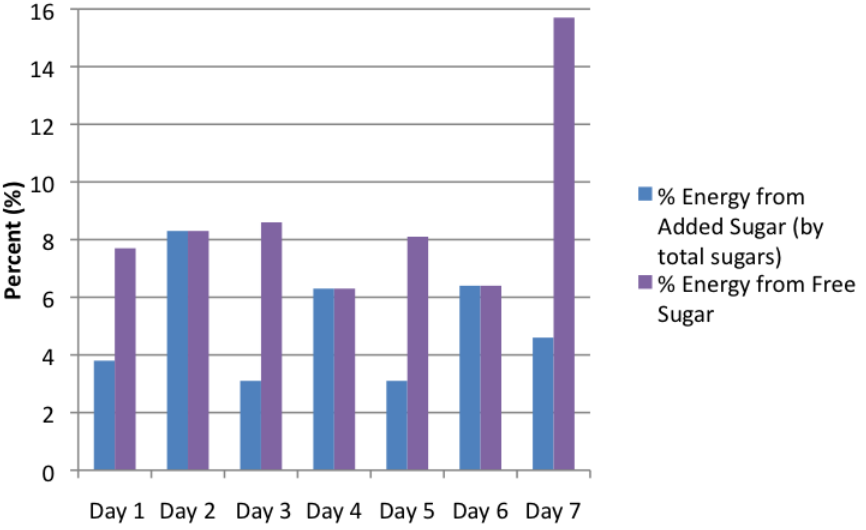
Figure 2. Percent energy from added sugar versus free sugar in the USDA sample menu by